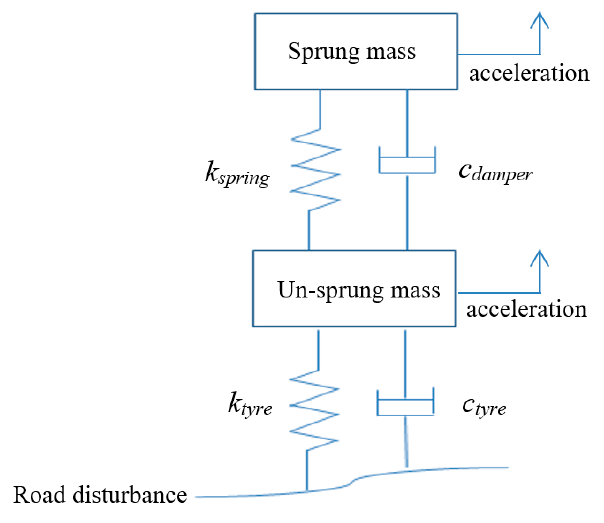
Figure 1. Schematic diagram of vehicle frontal suspension.